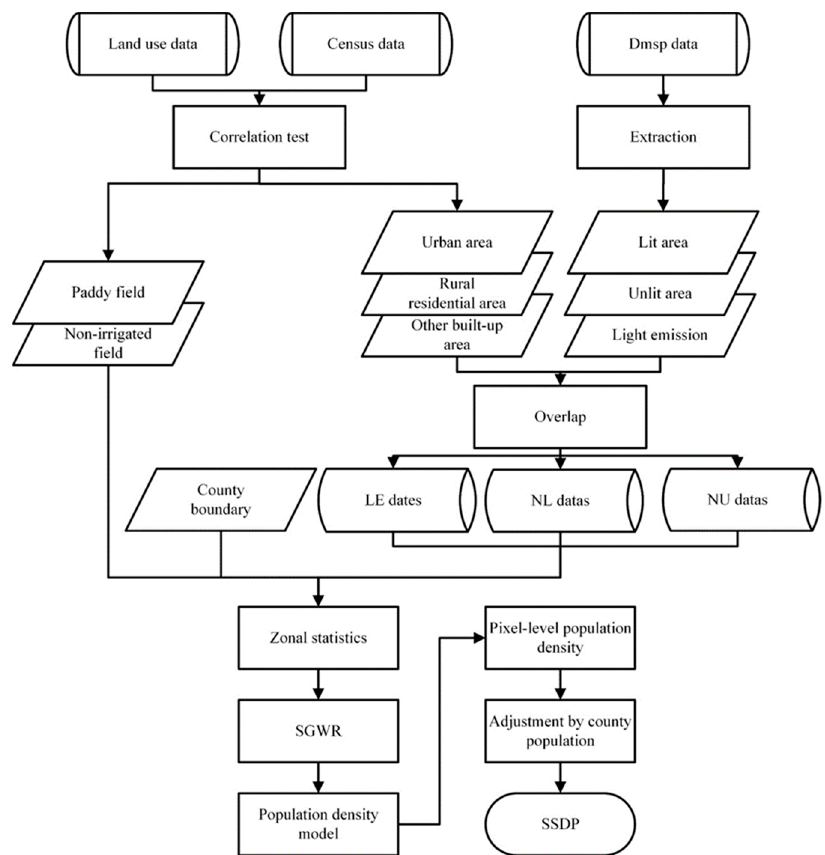
Figure 2. Flowchart for modeling the population in this study.